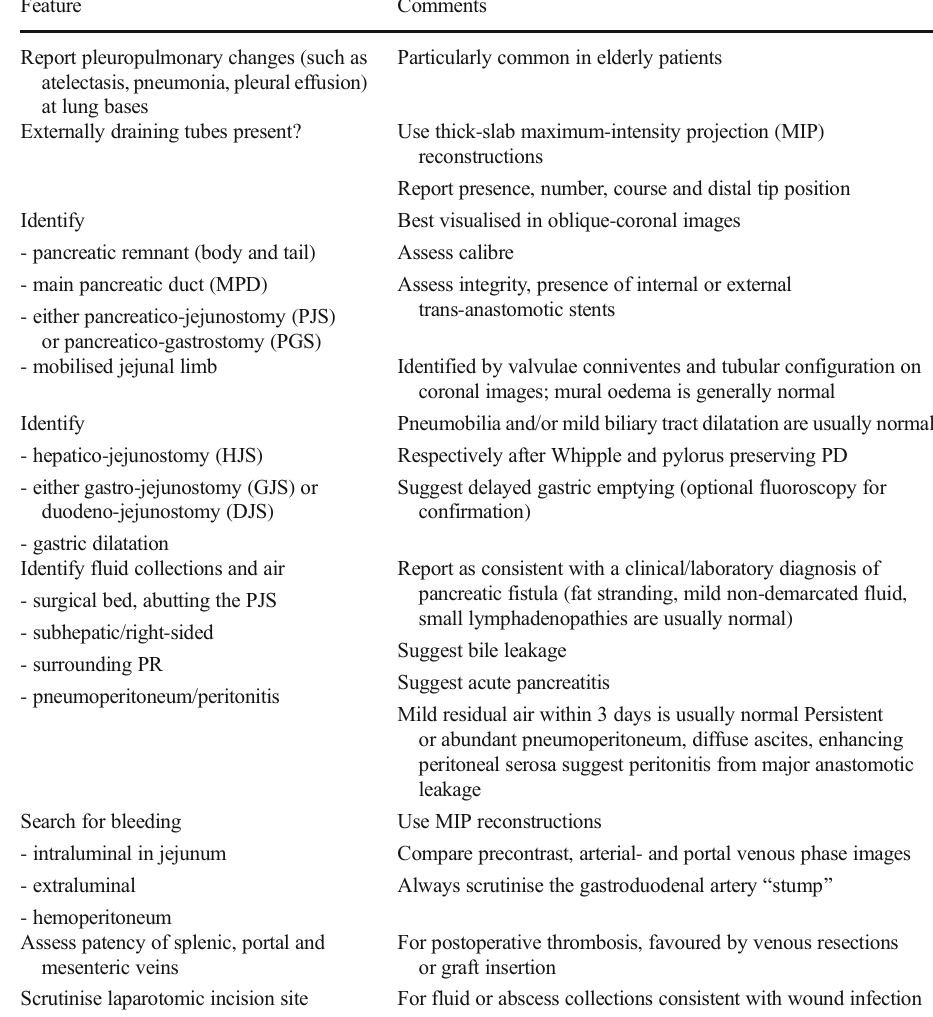
Table 1 Checklist for interpretation of early CT after pancreatico-duodenectomy (PD)